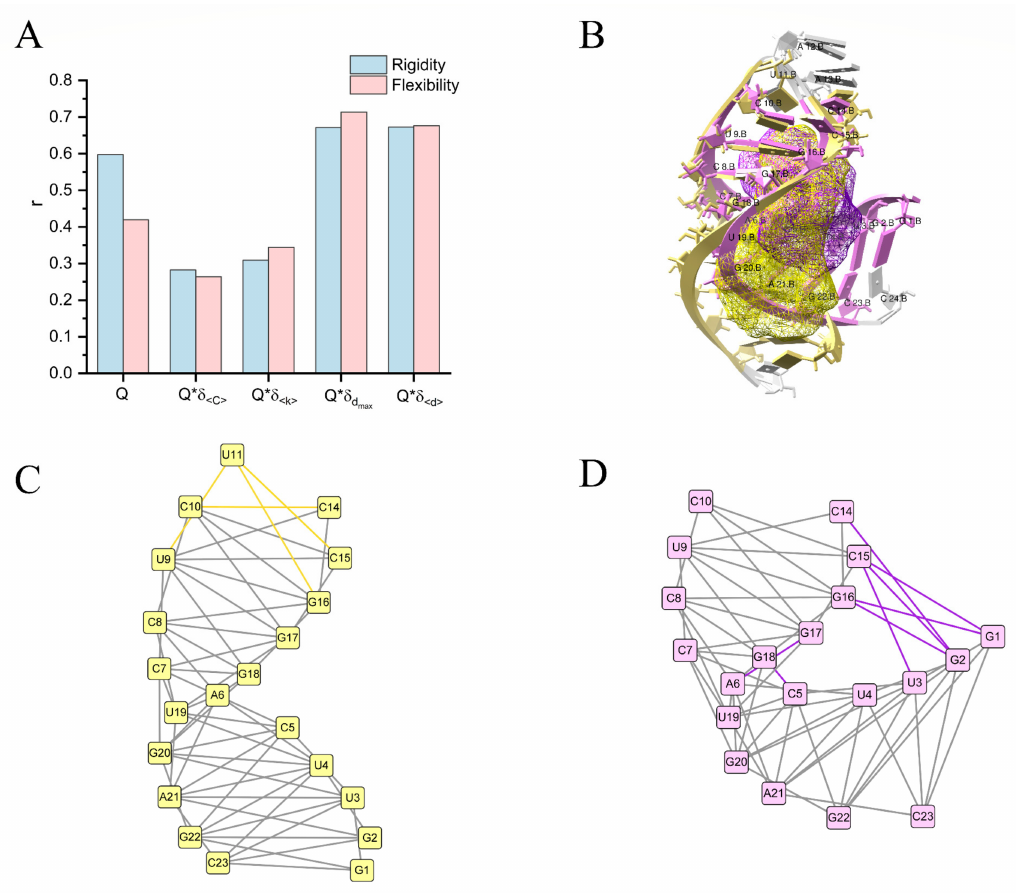
Figure 6. ( A ) The Pearson correlation coefficients (r) between RMSF and Q, Q ∗ σ < C > , Q ∗ σ < k > , Q ∗ σ d , and Q ∗ σ < d > , respectively. ( B ) The nucleotides forming the yellow pocket in NMR max structural model 1 (PDB code: 1NYB) are colored yellow, and those forming the purple pocket in NMR structural model 10 (PDB code: 1NYB) are colored purple. The nucleotides that do not form the pockets are colored gray. ( C , D ) The pocket networks of NMR structural model 1 (PDB code: 1NYB, colored yellow) and NMR structural model 10 (PDB code: 1NYB, colored purple). The overlapping edges between NMR structural model 1 and NMR structural model 10 are colored gray, and the different edges are colored yellow and purple,